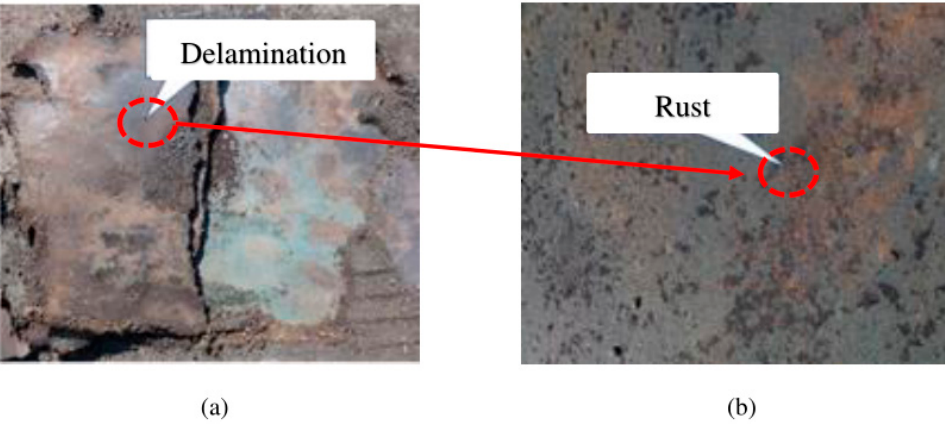
Figure 3. An area with delamination between the deck pavement and the steel deck plate: ( a ) a delaminated area; ( b ) steel plate rusted.